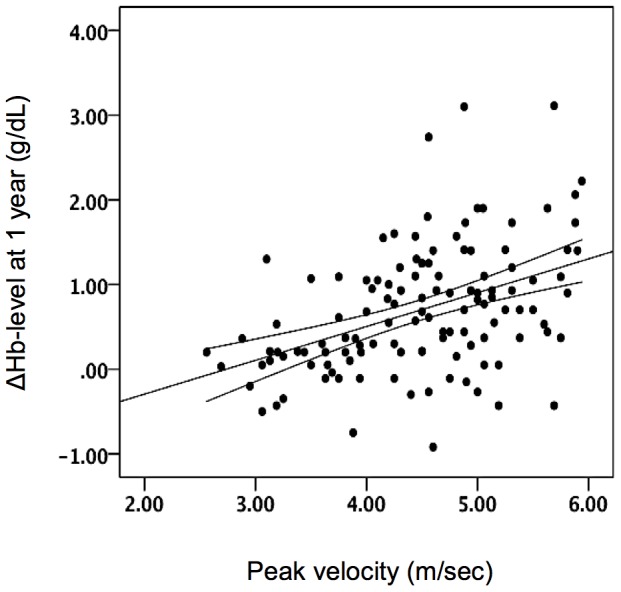
Association between peak AV velocity (m/sec) and ΔHb-level (g/dL) at 1 year after TAVI.A positive correlation between ΔHb-level at 1 year and peak AV velocity was found – the diagnonal solid line represents the regression line and the dashed lines are approximate 95% confidence intervals.